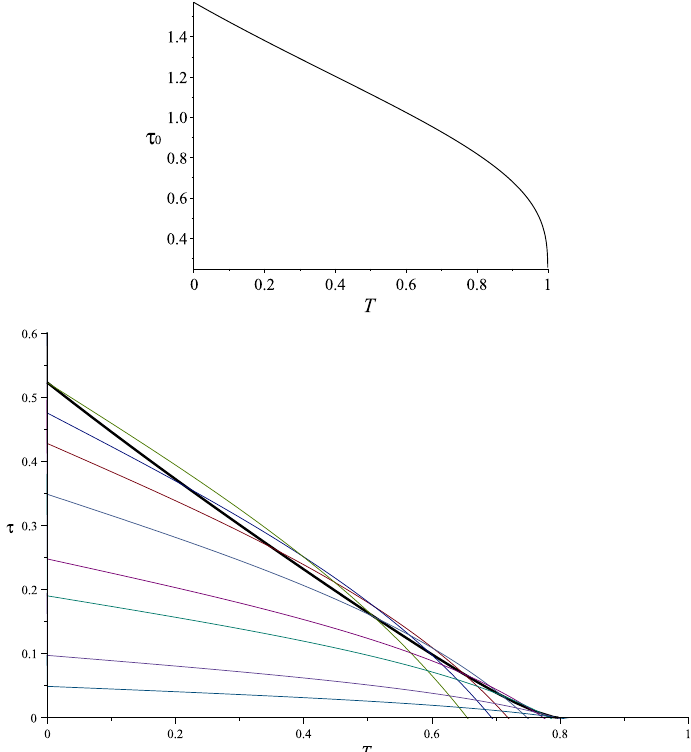
Figure 9 . Critical value of (cid:28) 0 vs T for d = 2 (left) and d = 4 (right). The thick curve on the right shows the phase boundary below which the black hole phase dominates. The other curves on the right show (cid:28) 0 ( T ) for (cid:12)xed values of r H , equal to 1,1.25,1.5,2,3,4,8, and 16 from top to bottom on the left. Where the curves overlap in the black hole phase region, the value of r H for the physical solution is always the larger